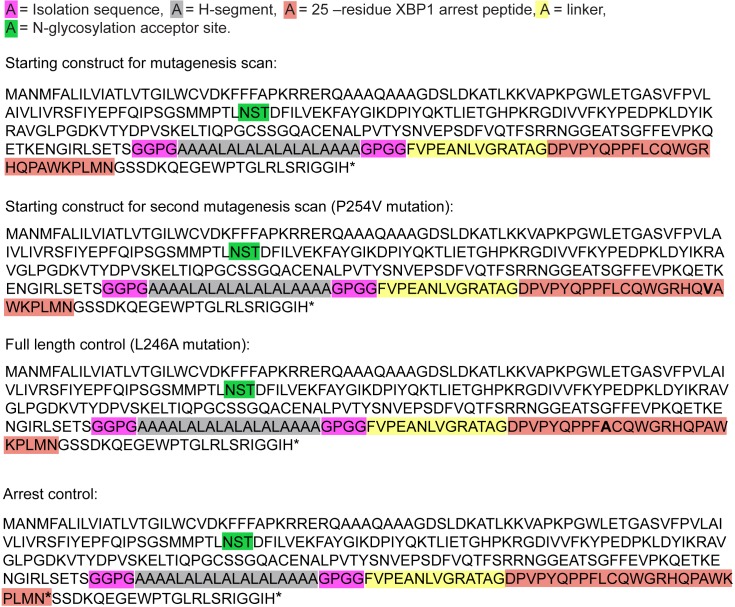
LepB-XBP1u constructs.Amino acid sequences of the LepB-XBP1u[L = 43] constructs used in the mutagenesis scans.